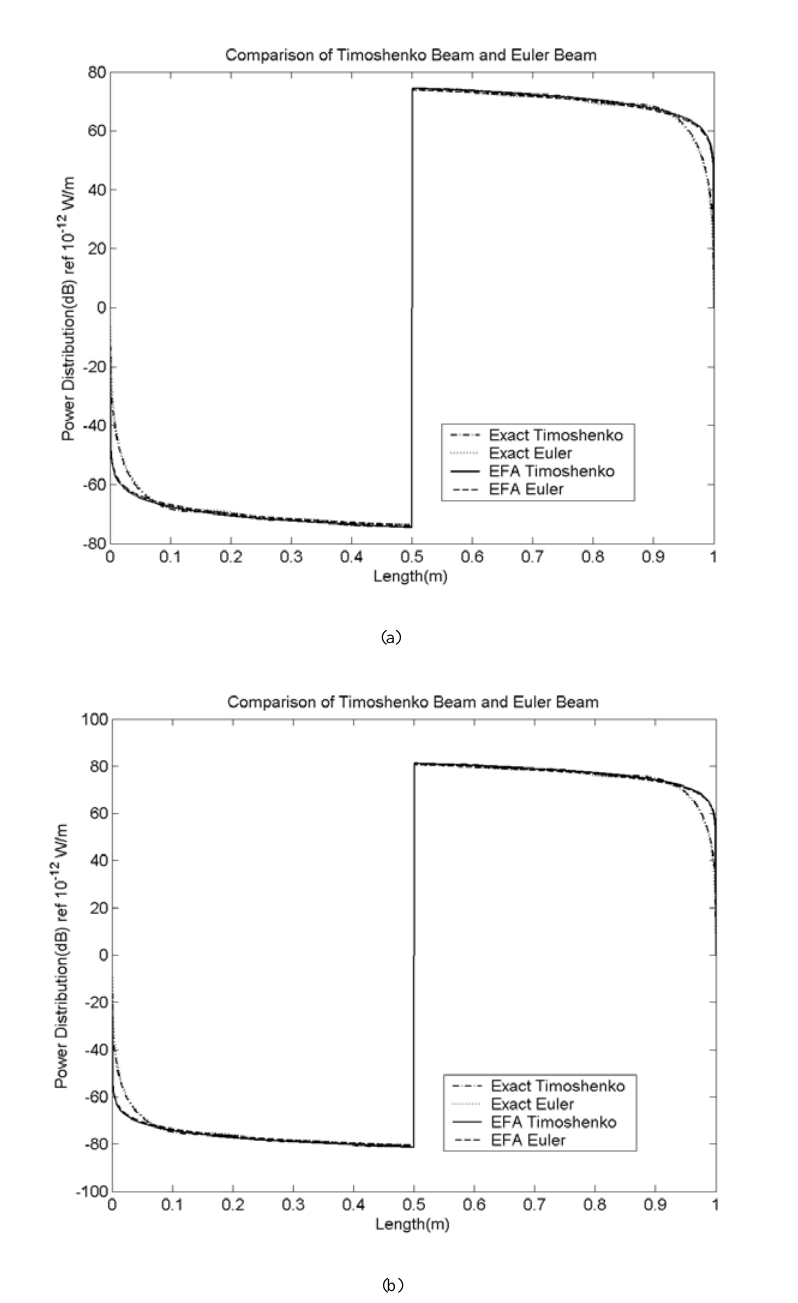
Fig. 5. The power level distributions of the Timoshenko beam ( L / H = 100, f c = 159 kHz) when f = 1 kHz. The reference power is 10 − 12 W/m: (a) η = 0.01, (b) η = 0.05, (c) η = 0.1, (d) η = 0.2: - · - · -, classical solution of the Timoshenko beam; ····· , classical solution of the Euler-Bernoulli beam, —, EFA solution of the Timoshenko beam; ---, EFA solution of the Euler-Bernoulli